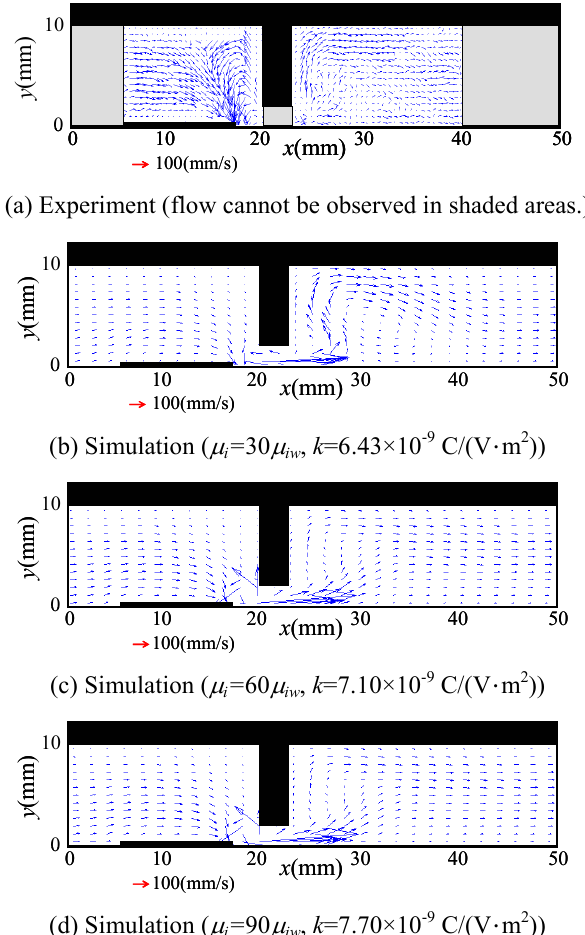
Fig.7 Comparison of measured flow filed with simulated ones and effect of ionic mobility on flow field ( V